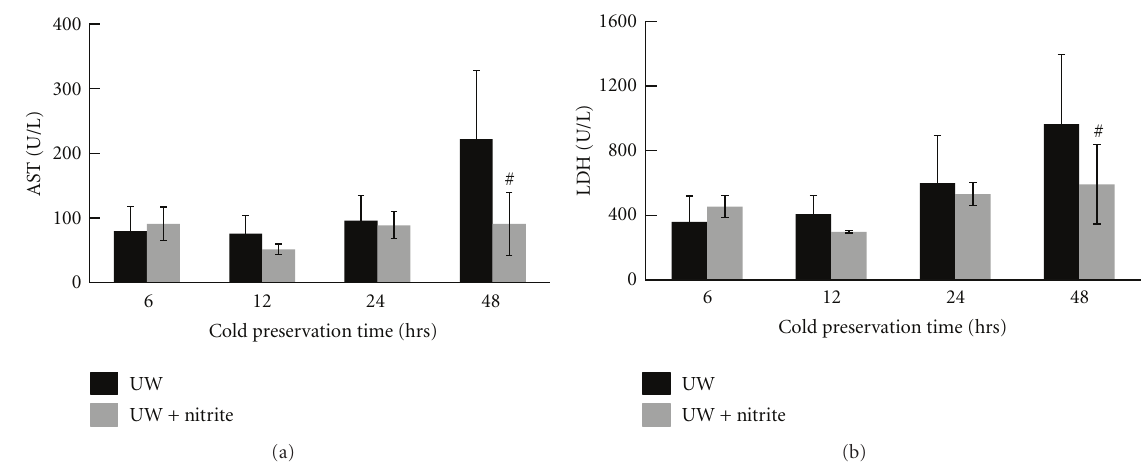
Figure 3: Nitrite-supplemented UW solution decreased graft enzyme release; UW solution supplemented with 25 µ M anion nitrite significantly decreased enzyme release at 48 hours (AST—221 ± . 97 versus 76 ± 40; LDH—991 ± 420 versus 578 ± 292). Data are expressed as mean ± SE. # P < 0 . 05 for corresponding